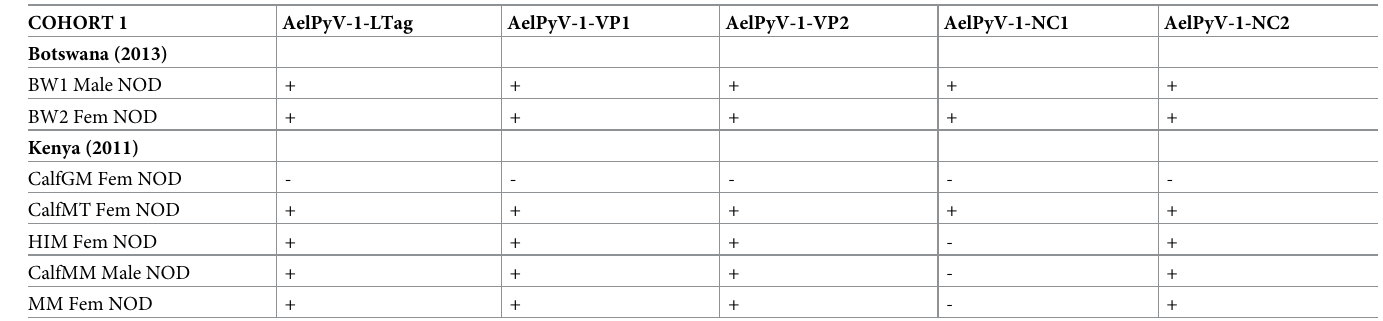
Table 2. Trunk nodule biopsies from wild elephants (collected by Virginia R. Pearson).